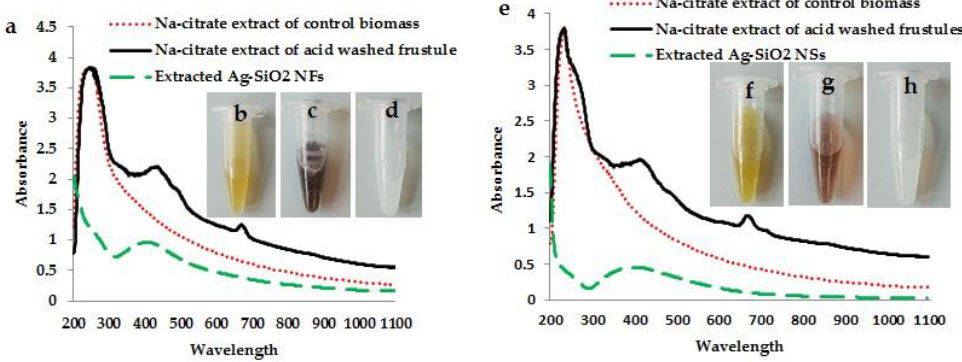
Figure 3. Absorption bands of control, Ag treated, and H 2 O 2 washed frustules extracts of G. flavovirens in Uv-vis spectroscopy ( a ). Uv-vis spectra of sodium citrate extracts of control, Ag treated, and H 2 O 2 washed frustules of G. mutabilis in 200–1100 nm wavelength range ( e ). Sodium citrate extracts of control cells ( b , f ), metal treated cells ( c , g ) and cleaned frustules ( d , h ) of G. flavovirens and G. mutabilis ,